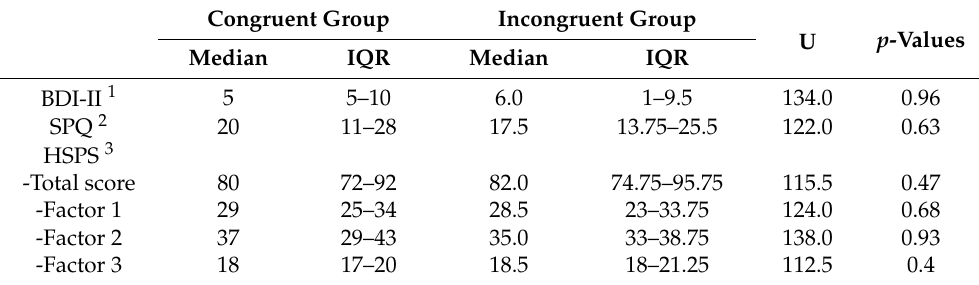
Table 1. Group comparison of psychological assessment.